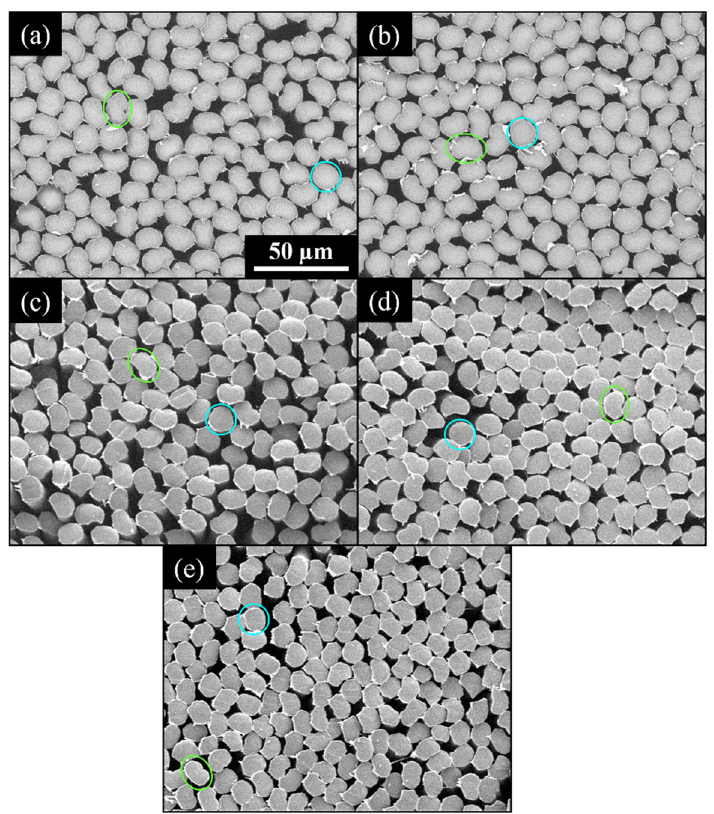
Figure 3. SEM images showing the cross-sectional shape for ( a ) 30C-7×, ( b ) 30C-8×, ( c ) 30C-9×, ( d ) 30C-10×, and ( e ) 30C-11×. All images are at the same scale. An example of a circular (blue) and bean-shaped (green) cross-section has been indicated.